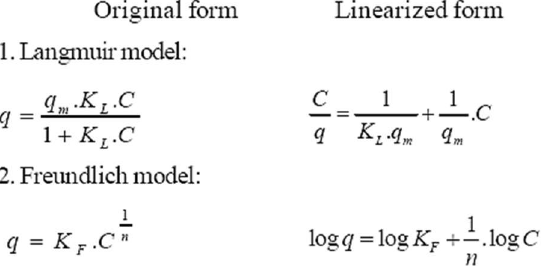
Figure 2. The transformation of each adsorption isotherm from original to linearized forms [51].